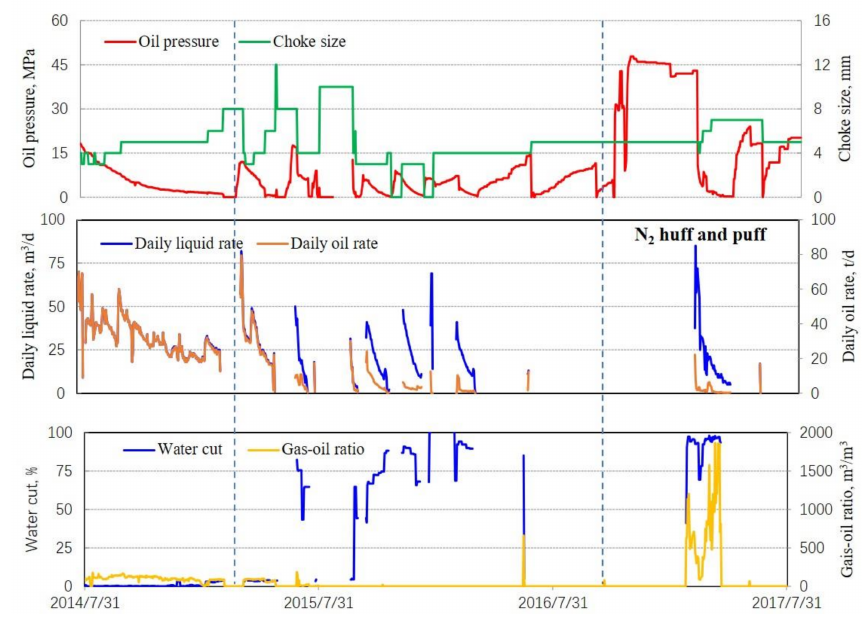
Figure 3. Actual production performance of N 2 huff-n-puff for a typical